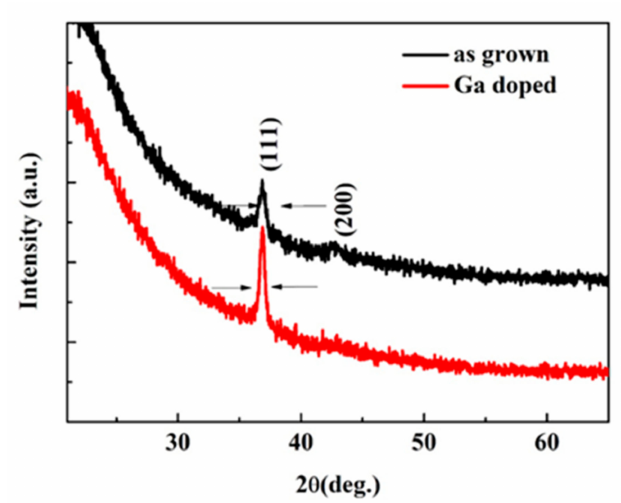
Figure 2. The XRD pattern of the ZnMgO sample with and without Ga